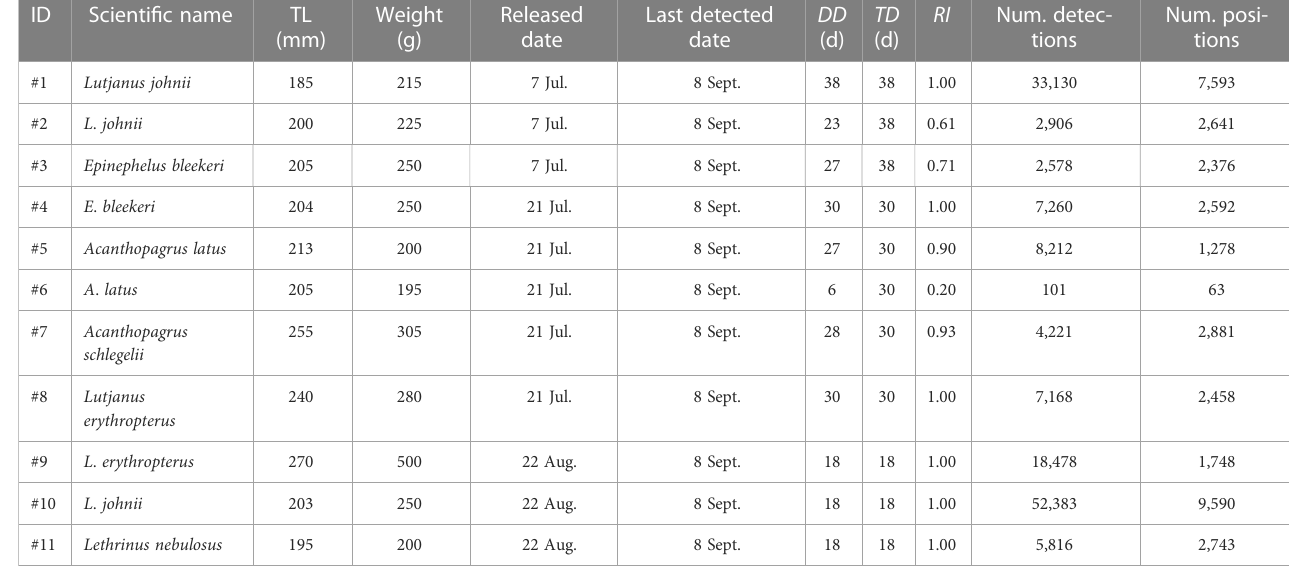
TABLE 1 Summary of the data for 11 reef fi sh tagged with acoustic transmitters between July and September 2017, including fi sh ID, species name, total length (TL), weight, released date, last detected date, detected days ( DD ), tracking days ( TD ), residency index ( RI ), number of (Num.) detections, and number of (Num.)